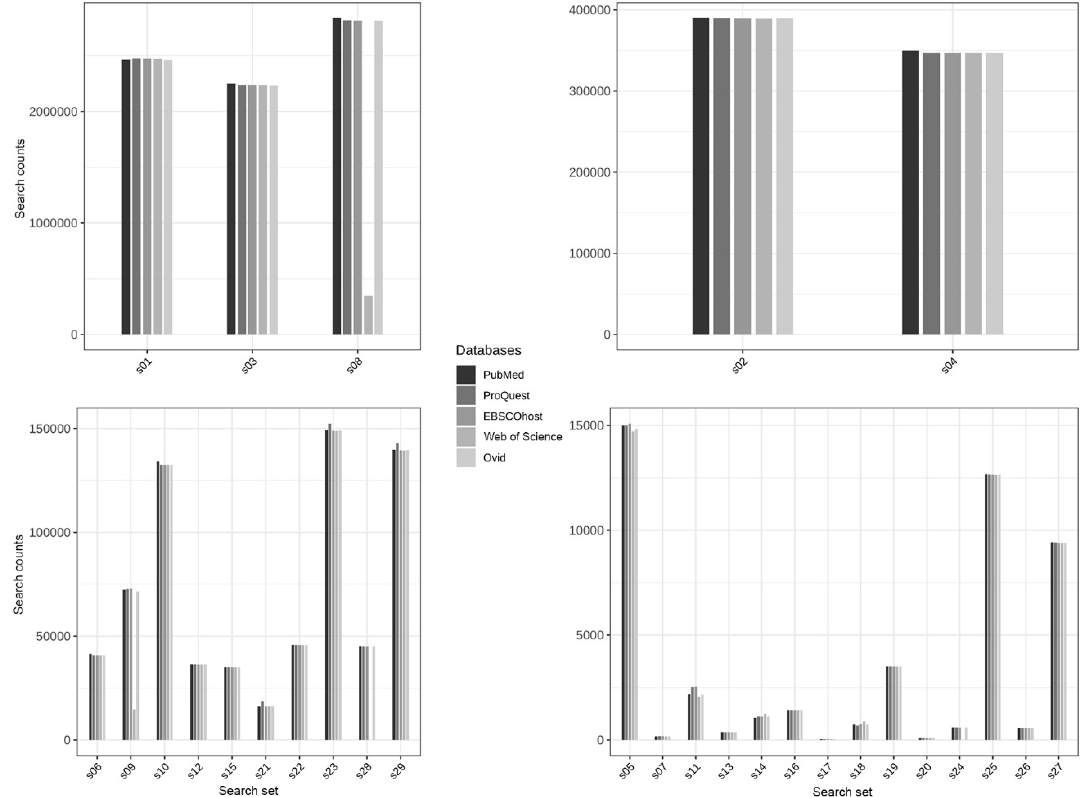
Figure 1 Total search result counts for each of the 29 search sets